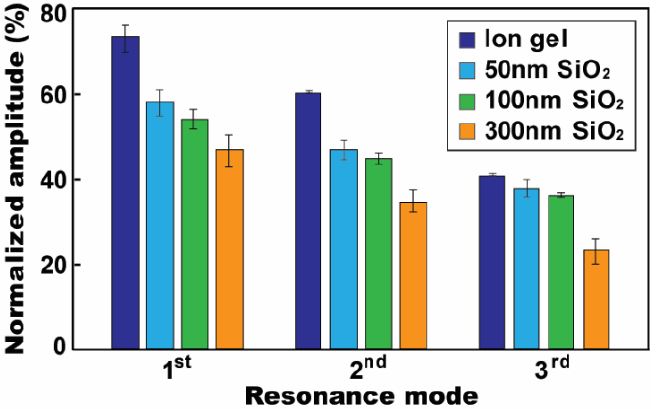
Figure 6. Normalized oscillation amplitude at the first three resonance frequencies of f 1 = 25 Hz, f 2 = 75 Hz, and f 3 = 120 Hz. Oscillation amplitude of the droplet was evaluated on various dielectric layers such as 8.3 µ m ion gel, and 50, 100 and 300 nm SiO 2 , while covering with a 150 nm Teflon layer. The use of the ion gel dielectric allows large electric energy stored across its dielectric capacitor, thus enhancing the oscillation performance much larger than a conventional dielectric material of the SiO 2 . A thinner SiO 2 layer also results in higher oscillation amplitude for all resonance frequencies. All experiments were conducted at V RMS = 26.5 V.